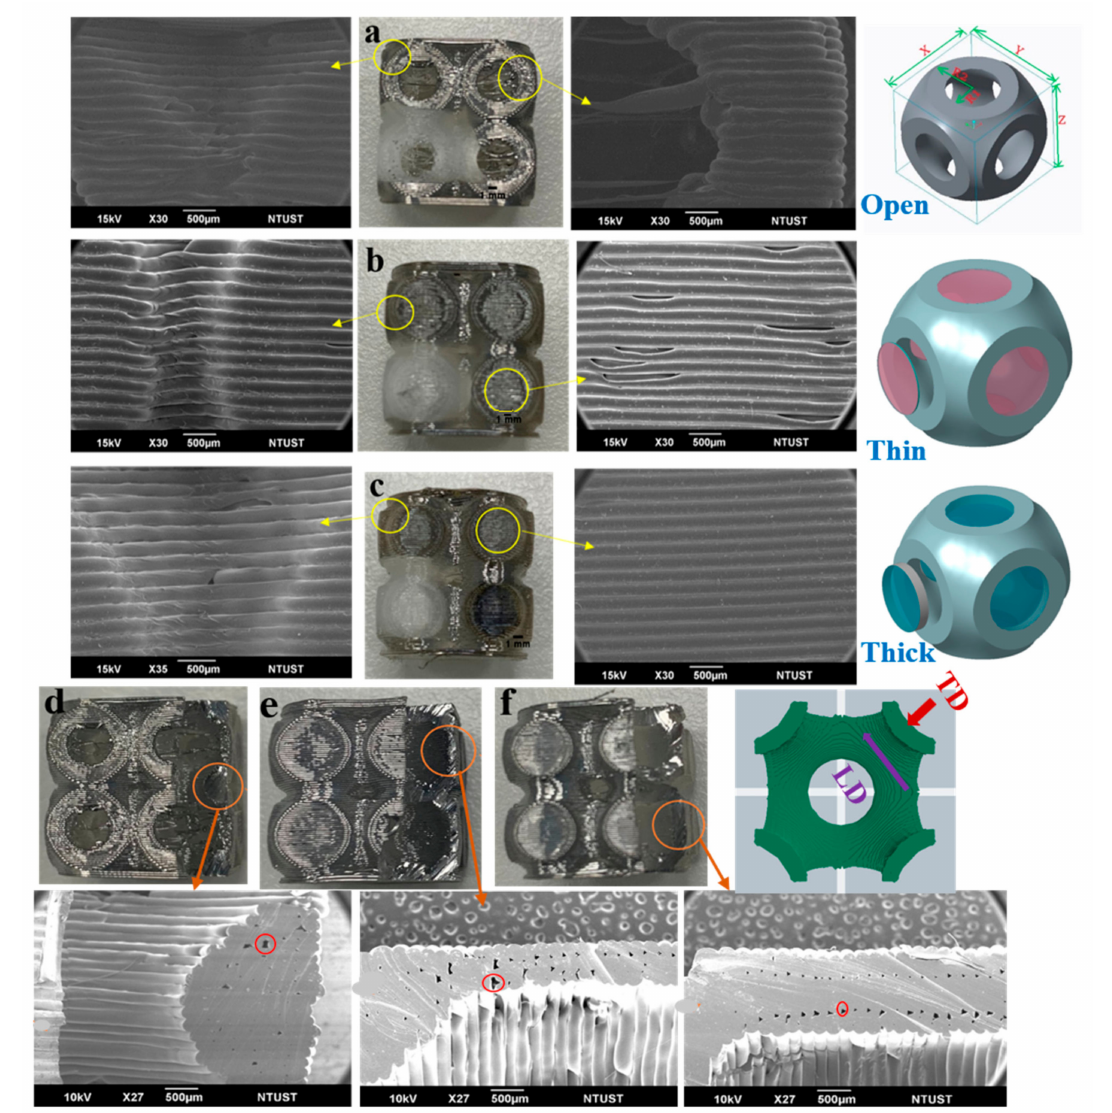
Figure 8. SEM images of the TPU layer deposition in both longitudinal direction (LD) and transversal directions (TD) ( a ) open-cell LD direction no defects are observed ( b ) thin-wall LD under-extrusion layer deposition is observed ( c ) thick-wall LD no defects are observed ( d ) in open-cell TD random micro-pores encircled with red colour is observed ( e ) continuous micro-pore encircled in red colour are seen in thin-wall TD ( f ) In thick-wall TD too micro-pores are observed. Longitudinal pores in the print direction were observed on the surface in both the LD and TD for the thin-walled closed-cell lattice structure (Figure 8b). In the TD, microscopic pores between the two layers of the outer and inner walls were present, as can be seen in Figure 8e. These microscopic pores were observed in a linear pattern up to the end of the thin wall. This effect was due to the under-extrusion of the material from the nozzle during the printing of this thin layer. Unlike the thin-walled structures, no longitudinal pores or layer peeling in the print direction were observed in the thick-walled structures, as seen in Figure 8c. In the TD, continuous microscopic pores were present in the inner and outer layers of the thick-walled lattice structure, as can be observed in Figure 8f. This was due to the small gap left during the connection of the infill to the boundary wall layer. However, these microscopic pores did not significantly affect the thick-walled closed-cell structural performance